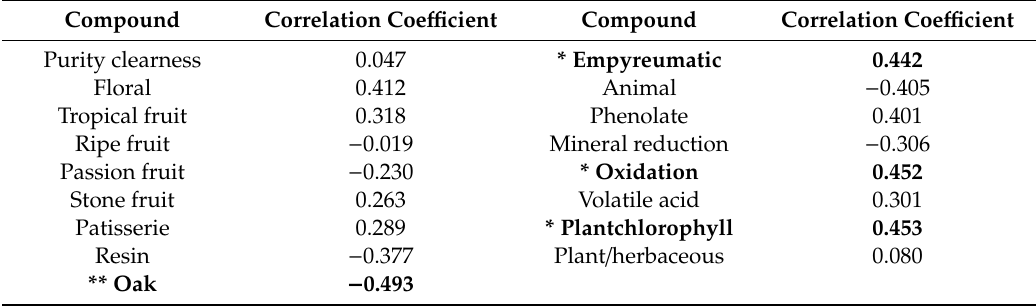
Table 3. Sensorial attributes from the sensory analysis performed on seventeen wine samples with correlation at a significant level of 90% with the olfactory “minerality” attribute (in bold letters with significant di ff erences; * p < 0.1; ** p <